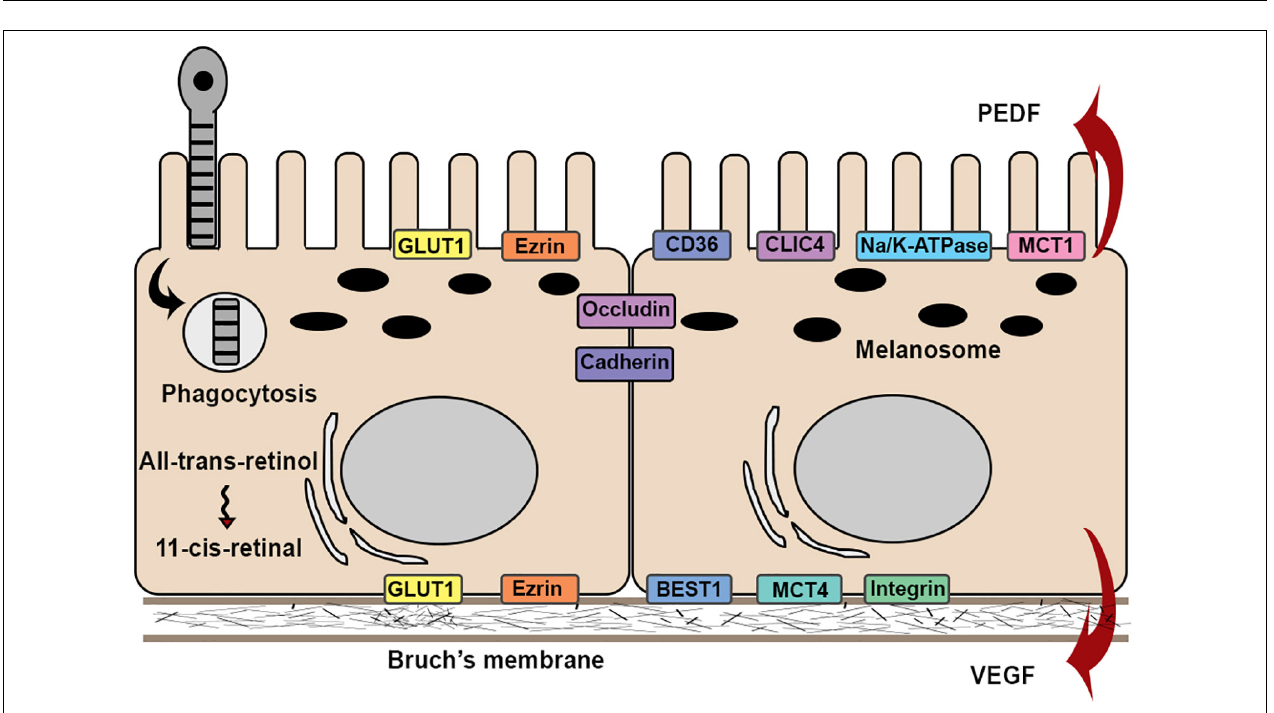
FIGURE 2 | Schematic illustration of the structures and functions in RPE cell. RPE cells attach to Bruch’s membrane in a single monolayer with apical microvilli and melanosomes, and basal nuclei. Barrier function is maintained by expression of occludin and cadherins. RPE cells exhibit physiological functions, such as phagocytosis and visual cycles. RPE cells exhibit functional polarity by polarized secretion of proteins and apical-basal distribution of membrane